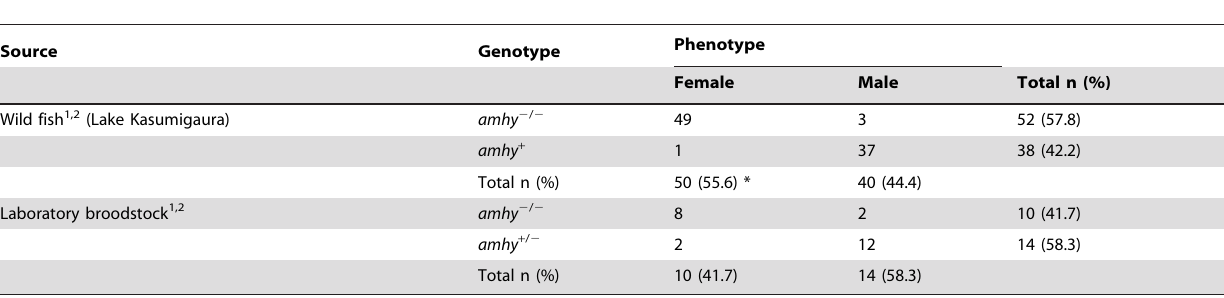
Table 1. Relationship between phenotypic (gonadal) sex and amhy genotype in wild pejerrey and laboratory-reared broodstock.